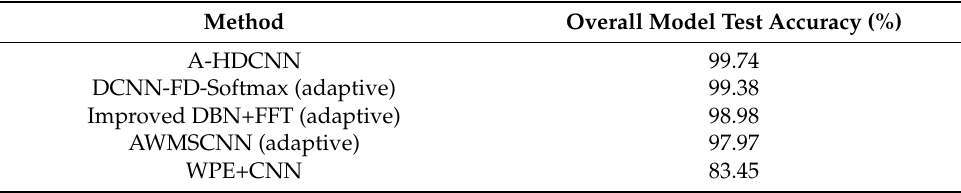
Table 8. Comparison of the overall performance of the A-HDCNN model with other adaptive diagnosis